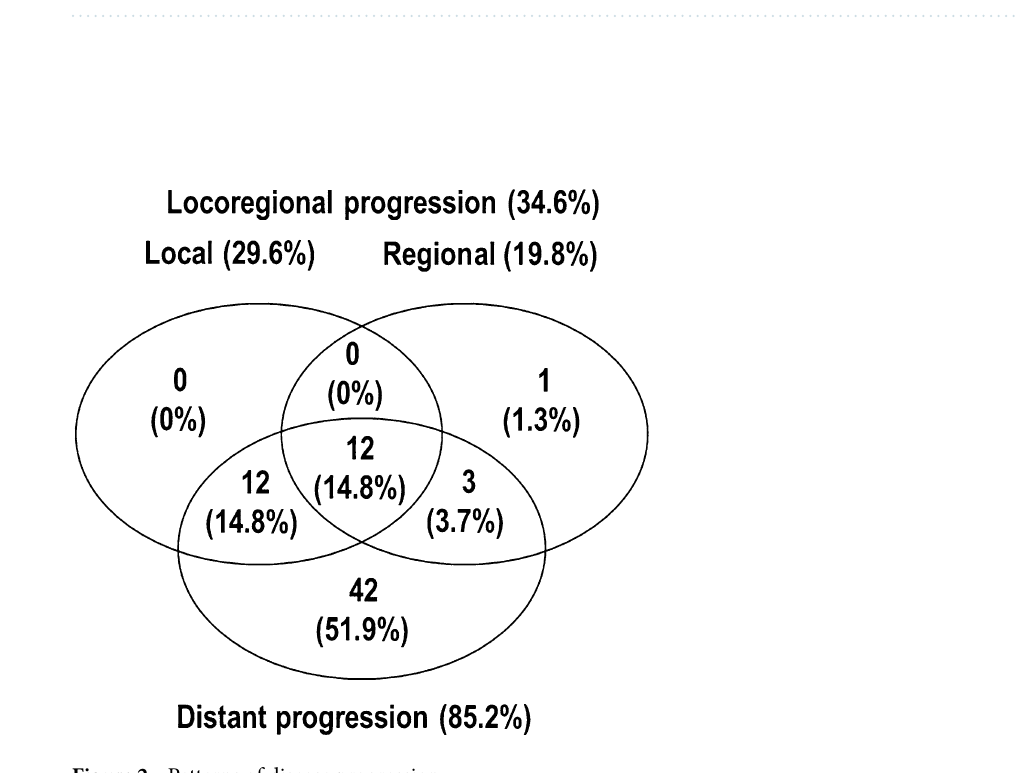
Figure 2. Patterns of disease